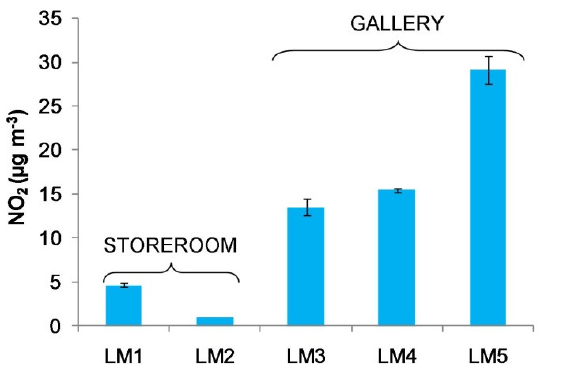
Fig. 3 . NO 2 concentration obtained in the LTMCM. Values represent the average from two parallel samplers. For